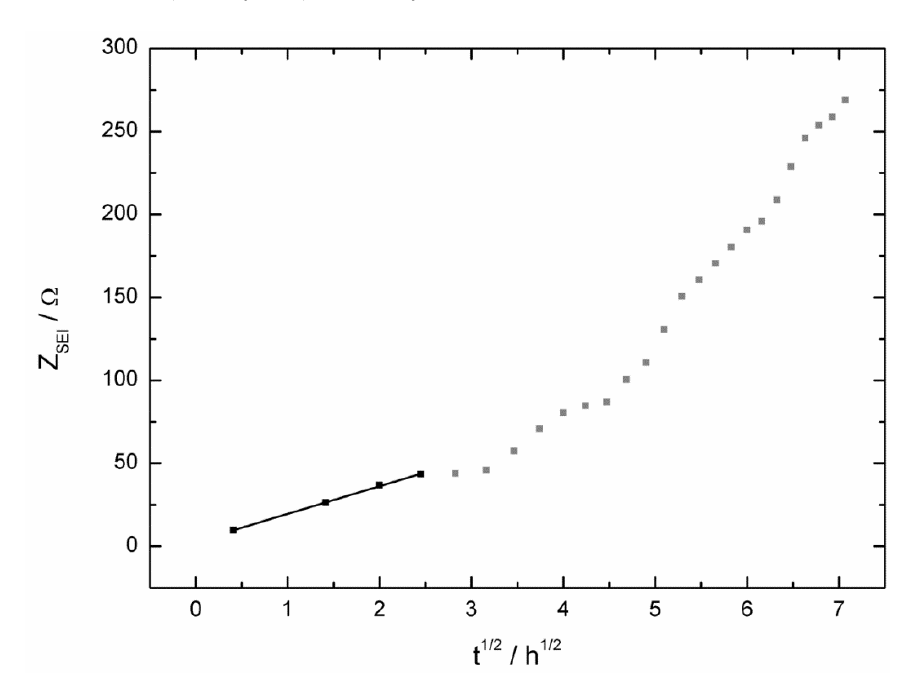
with immersion time, for the 1 M SEI